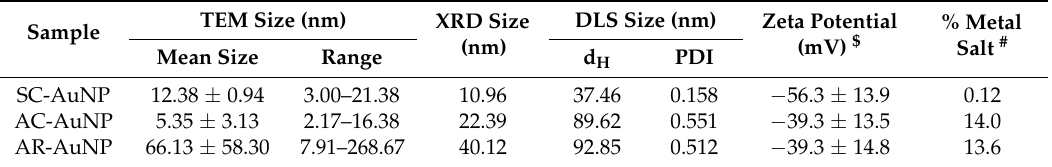
Figure 8. TEM images and NP size distributions obtained for ( a ) AC-AuNPs and ( b ) AR-AuNPs. AC: Aqueous extract subjected to organic solvent partitioning. AR: simple aqueous extraction. Table 3. AuNP data obtained including mean AuNP sizes as determined by TEM, XRD and DLS, as well as Zeta potential measurements and supernatant metal salt percentages.